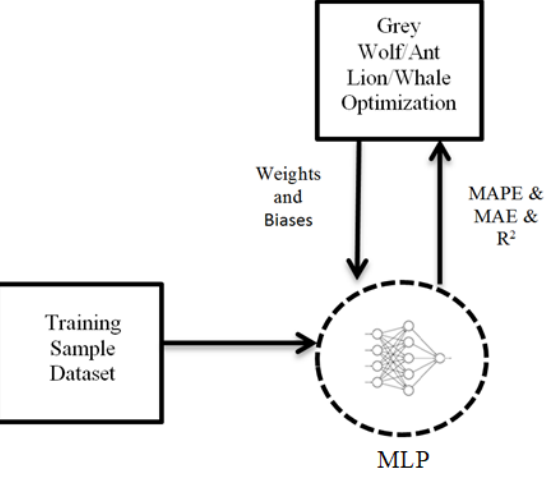
Figure 1. The architecture of the training samples.